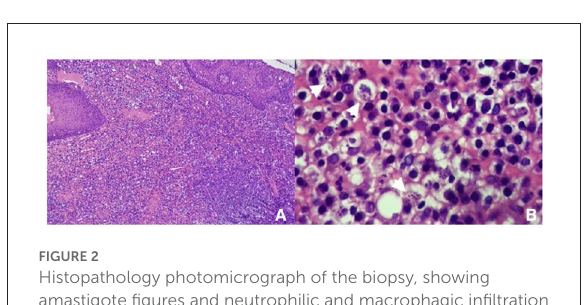
FIGURE2 Histopathology photomicrograph of the biopsy, showing amastigote figures and neutrophilic and macrophagic infiltration (A) 100 × and (B) 400 × .